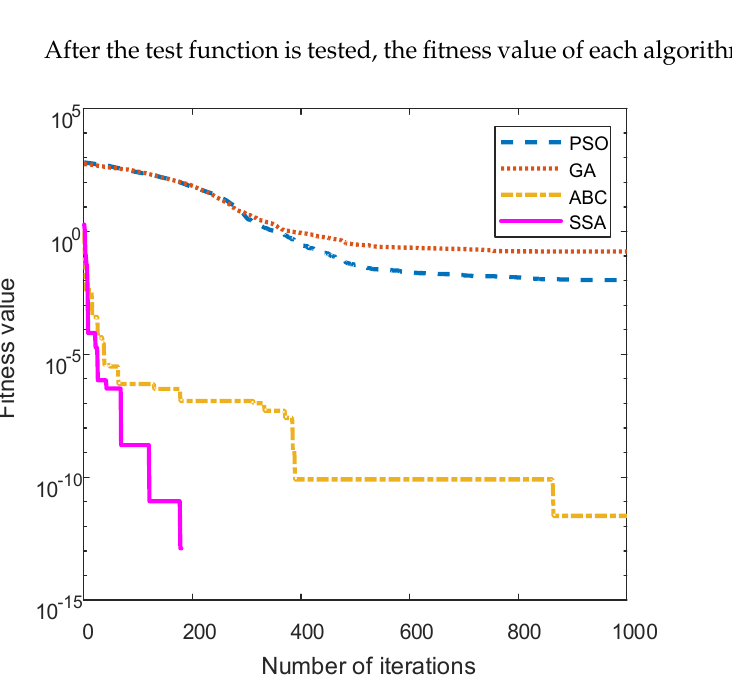
Figure 9. Fitness value of each optimization algorithm.